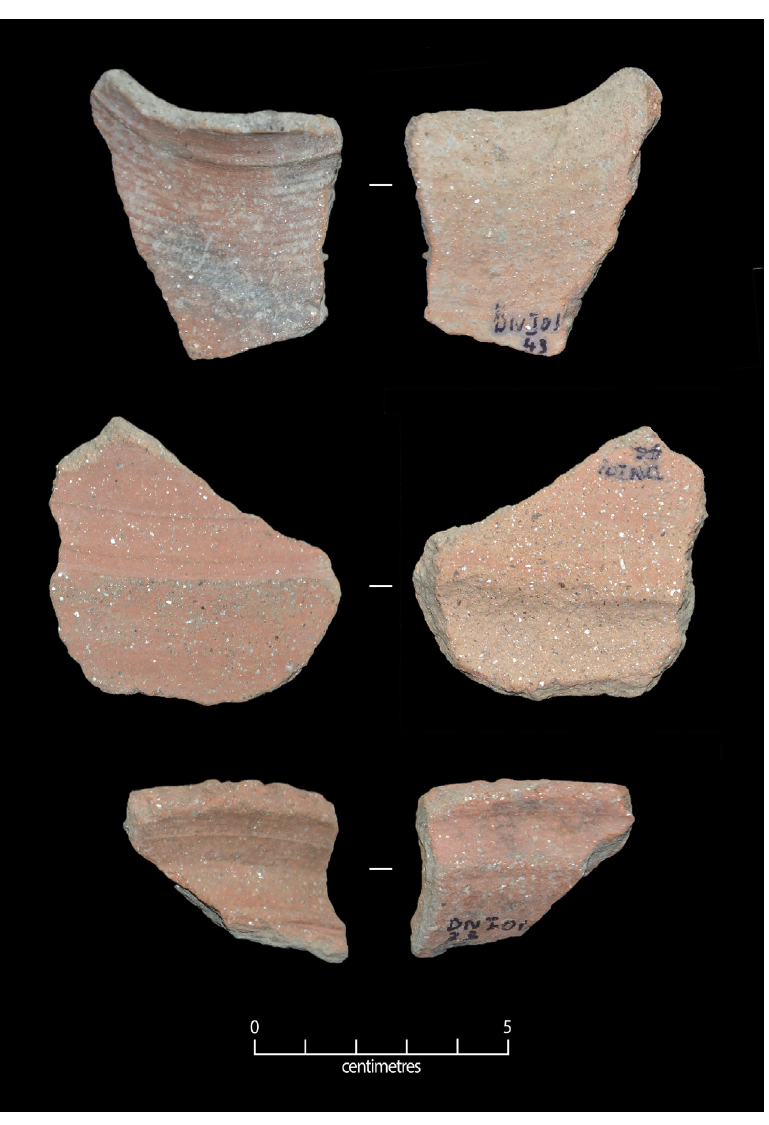
Figure 11: External and internal surfaces of Class 4 variant 6 potsherds (2 rims and 1 body